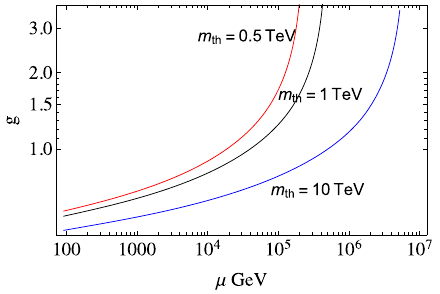
Fig. 3 The running of g in terms of μ , depending on m th . = ( 0 . 5 , 1 , 10 )